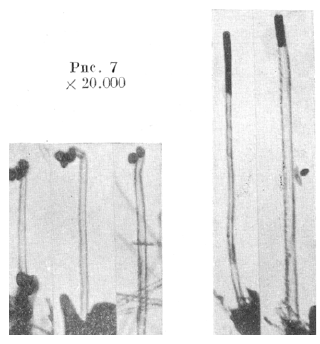
Figure 1. Hollow carbon fibers. Adapted from reference [7] with permission. Grobert,